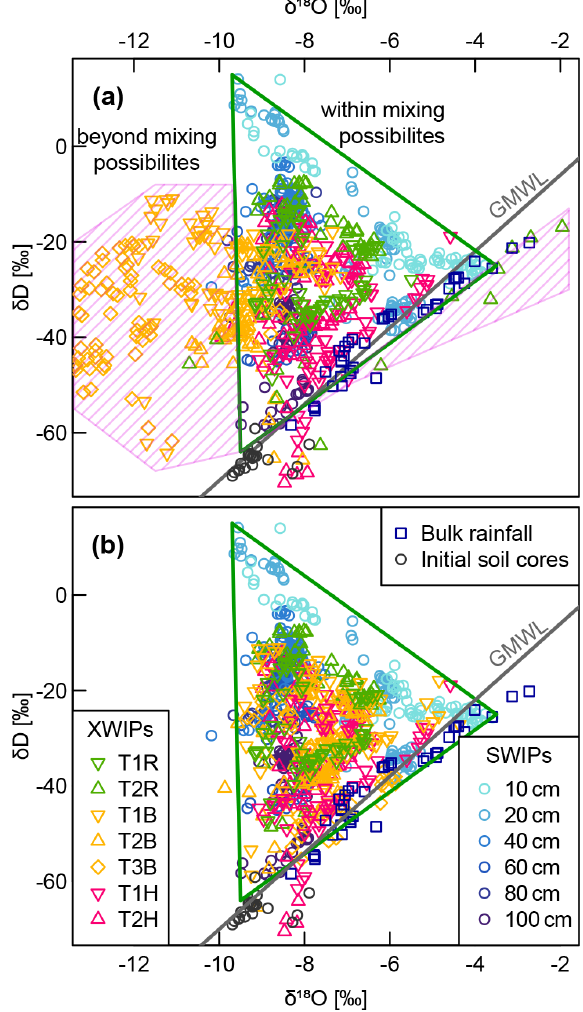
Figure A3. (a) Dual-isotope plot of the in situ (XWIPs in tree xylem and SWIPs in the soil) measurement data after volumetric moisture correction and normalization to the liquid phase combined with bulk rainfall samples and soil core data measured before the irrigation. The pink shaded area marks the area that contains implausible iso- topic xylem signatures, i.e., impossible to obtain by mixtures of the signatures measured within the soil water. Panel (b) shows the same data after manual removal of some data points and adding one or multiple offsets to the δ 18 O time series of T1B, T2B and T3B.